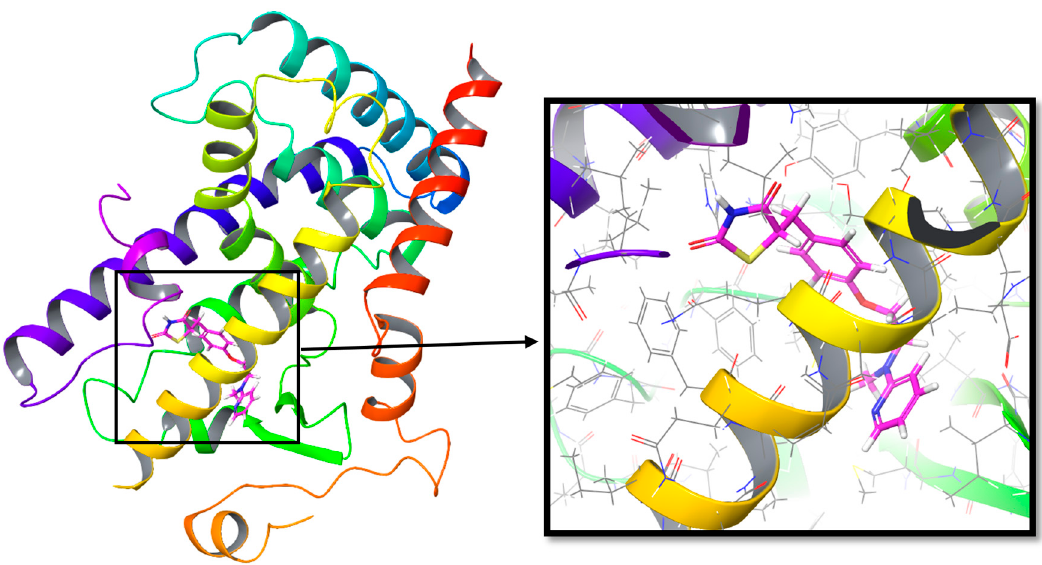
Figure 4. Cartoon representation of rosi (magenta) in the active site of PPAR- γ.